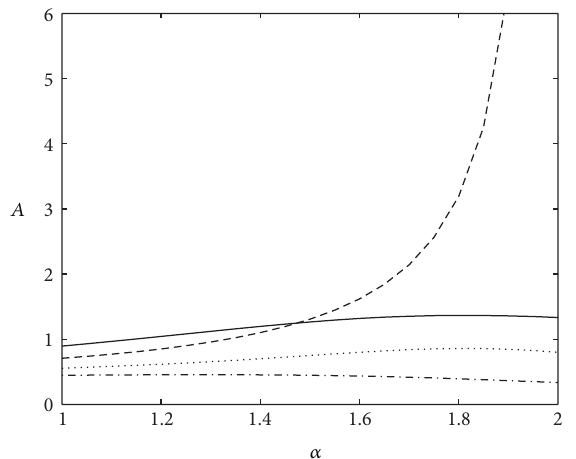
Figure 8: Surface of amplitude 𝐴(𝛼,𝜆) for 𝑏 = 𝑐 = 1